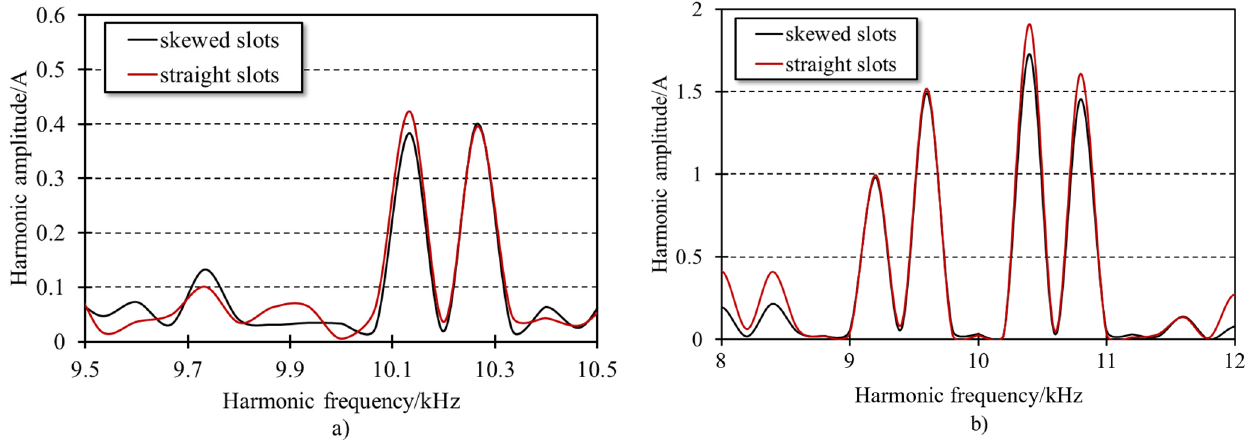
Figure 4. Sideband current of the current of two motors: ( a ) when speed is 1000 rpm; ( b ) when speed is 3000 rpm.